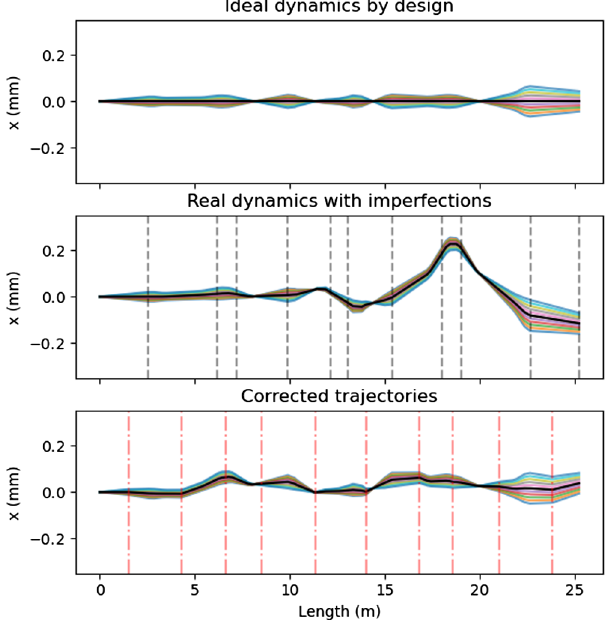
FIG. 6. Trajectory correction in a multibend achromat lattice: Trajectories in an ideal lattice (top), in a lattice with random misalignments (middle), and after correction by a TM-PNN (bottom). BPM and corrector positions are shown with black and red dashed lines respectively.